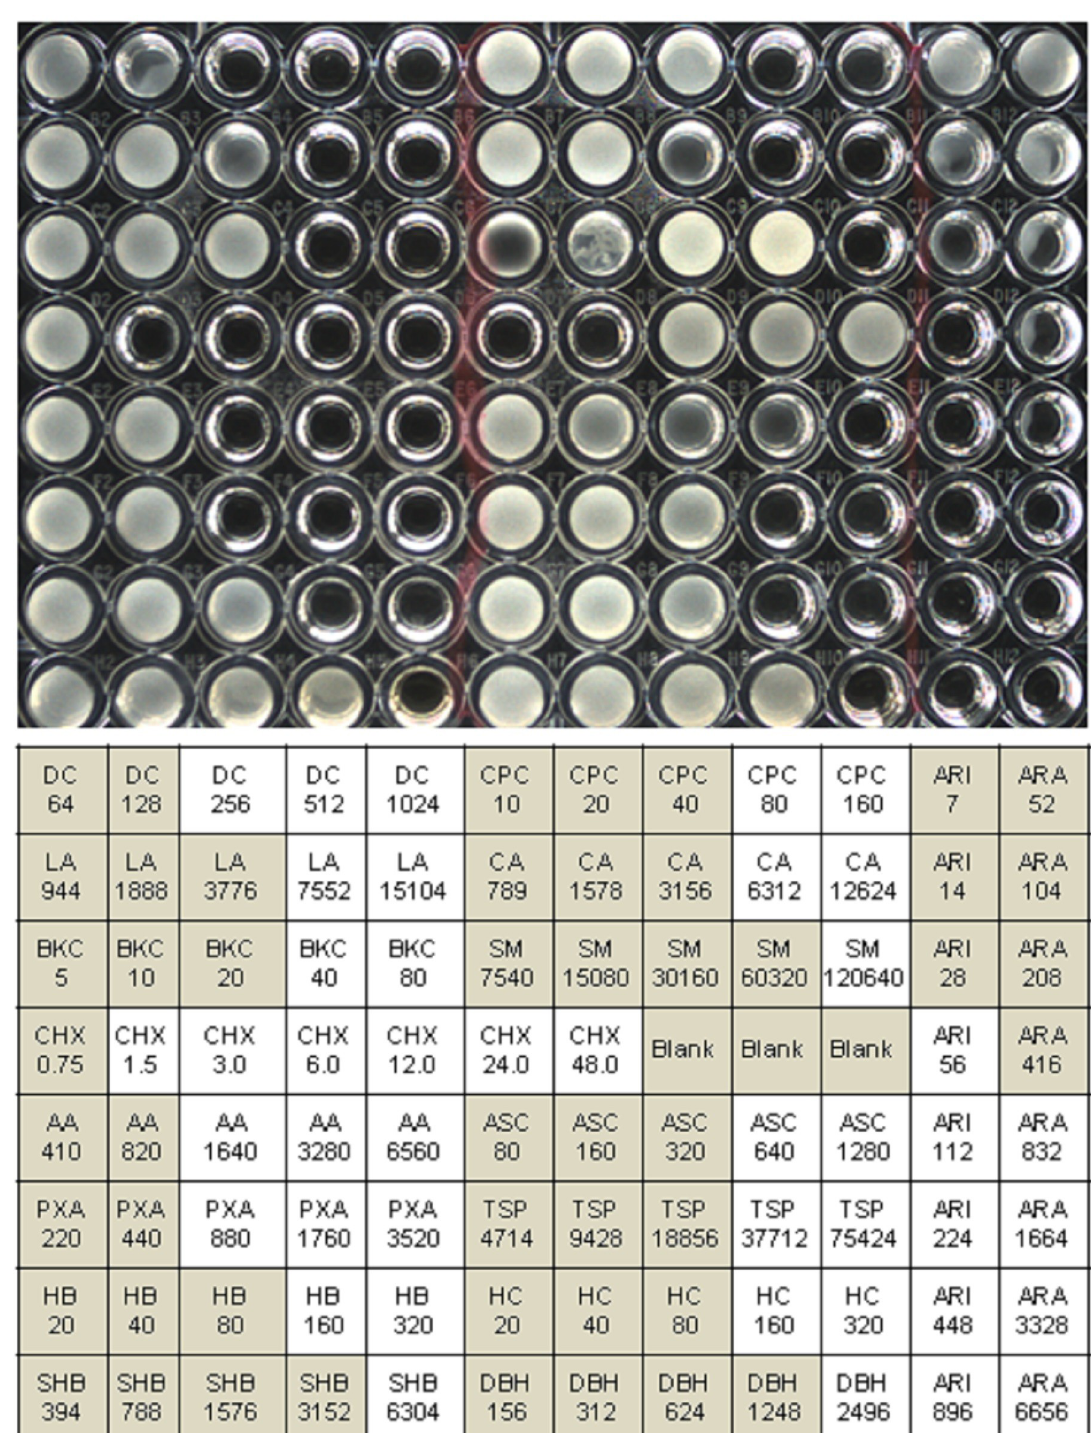
Fig 1. Example of 96 well biocide panel: Susceptibility assay of S . Heidelberg using 17 biocides panel. Panel A is an image of biocide panel inoculated with S . Heidelberg after 18–24 hrs incubation. Panel B is showing the distribution of 2-fold serial dilutions of 17 biocides in 96-well plate and interpretation of results. Gray region (turbid well) is indicating growth and white region (clear well) is indicating no growth.